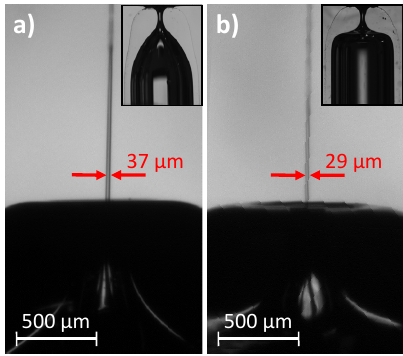
Figure 13. Steady jet emitted by the two GDVNs devices with ( a ) Nozzle A and ( b ) Nozzle B. The water inner flow rate is Q = 20 mL/h and the air pressure drop is ∆ p = 150 mbar.